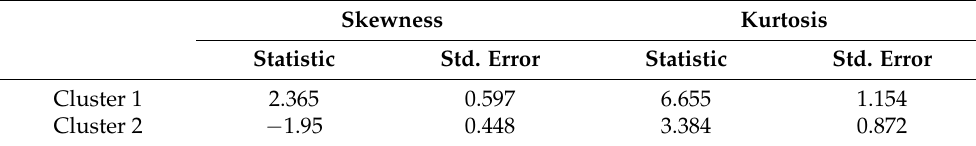
Table 5. Descriptive statistics.